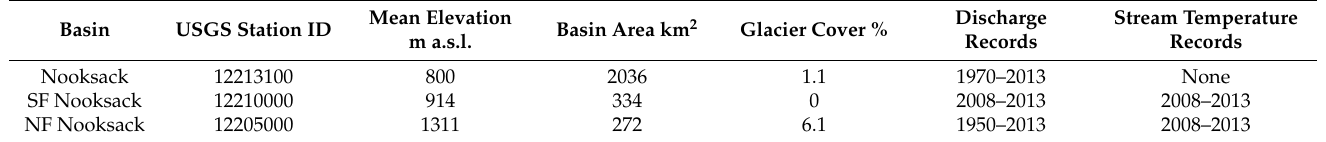
Table 1. USGS stations characteristics and data records